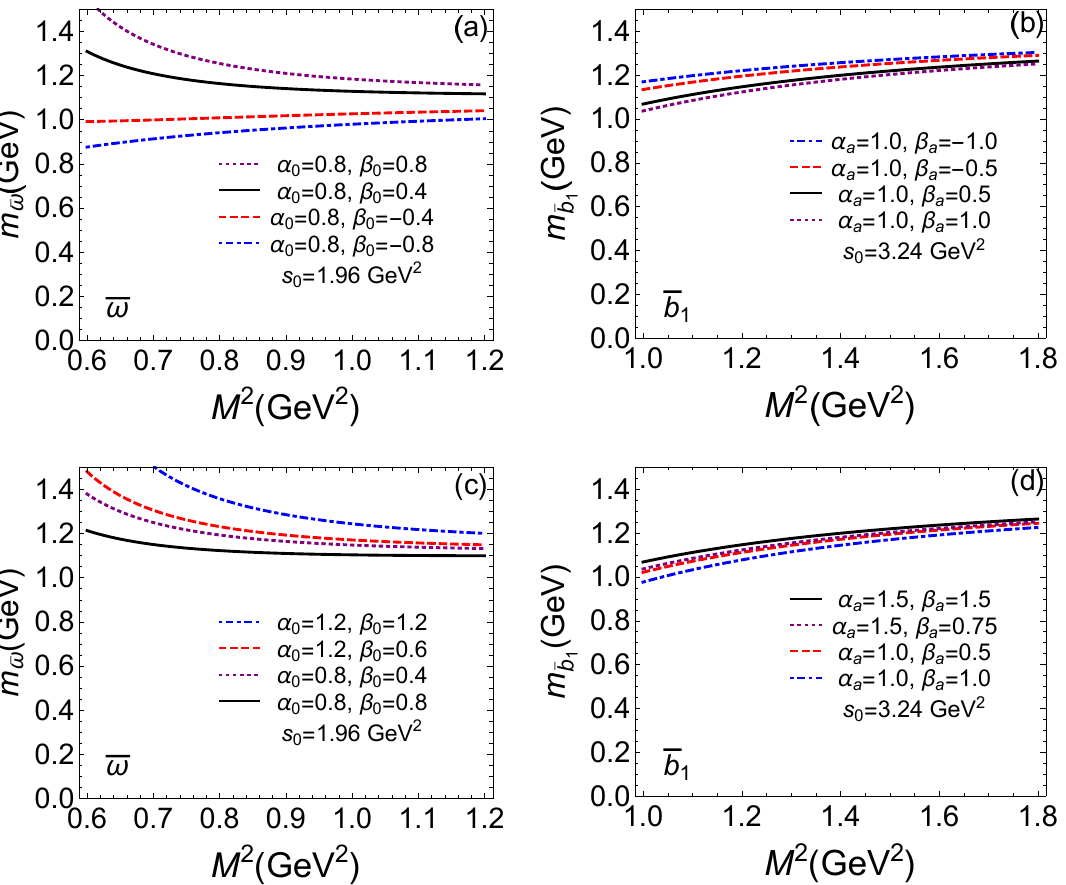
Figure 3 . Mass sum rules for spin-1 meson states interpolated by the tensor current ( c = 1). (a,c) isoscalar parity-odd channel (¯ ω ) with s with s = 3 . 24 GeV 2 0